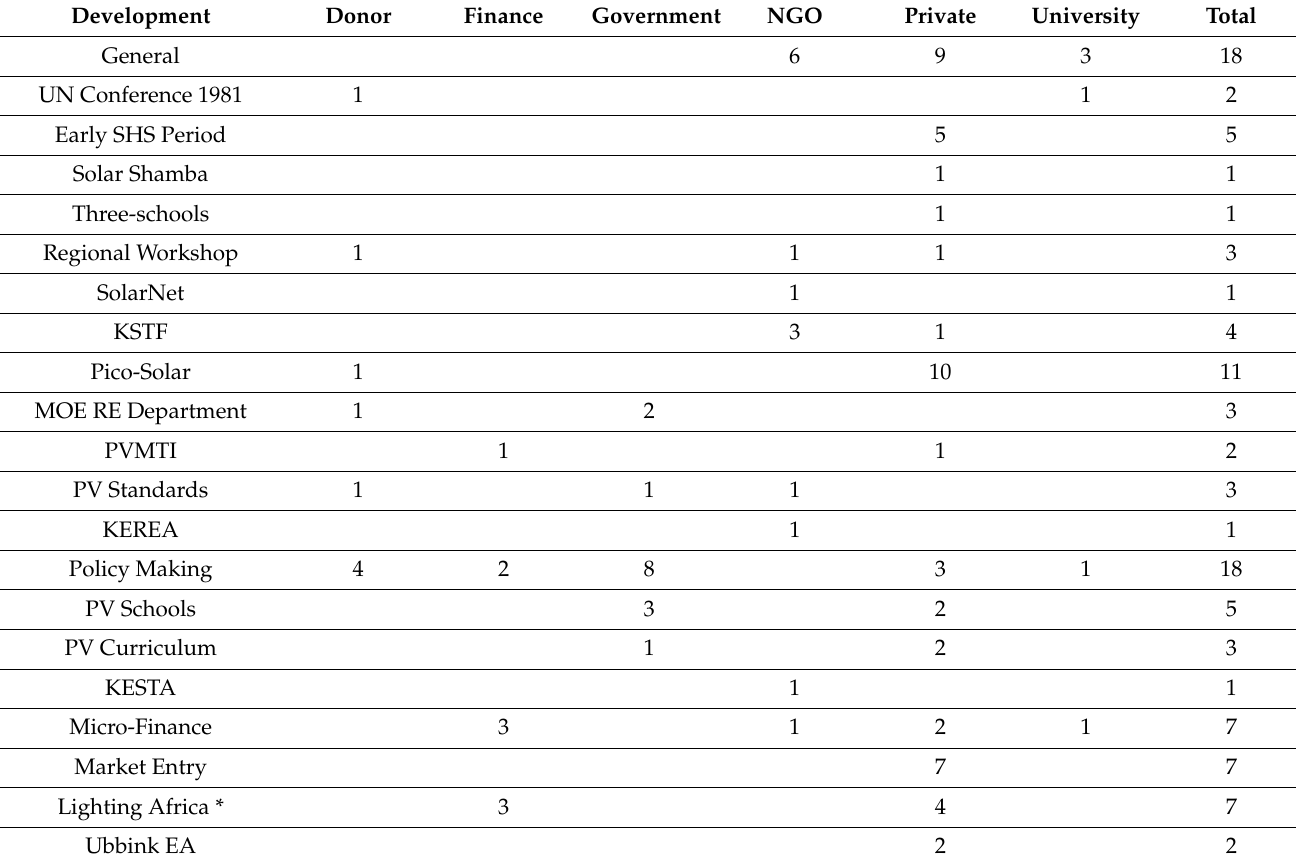
Table 1. Summary of interview topics, interviewee type and number of